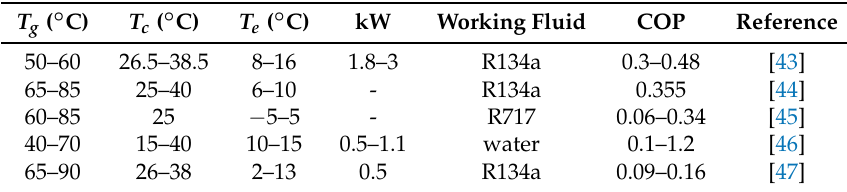
Table 1. Low operating temperatures of an ejector.